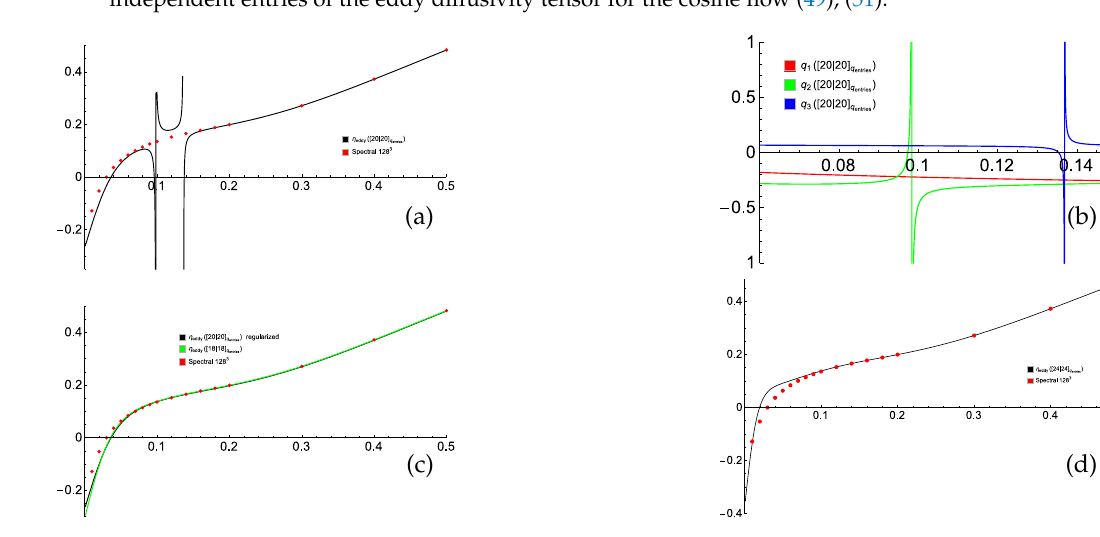
1/2 (vertical axis) versus n > 0 (horizontal axis) for five ( D l ) ( 2 n − 1 ) / ( D l ) ( 2 n + 1 ) mk mk | |